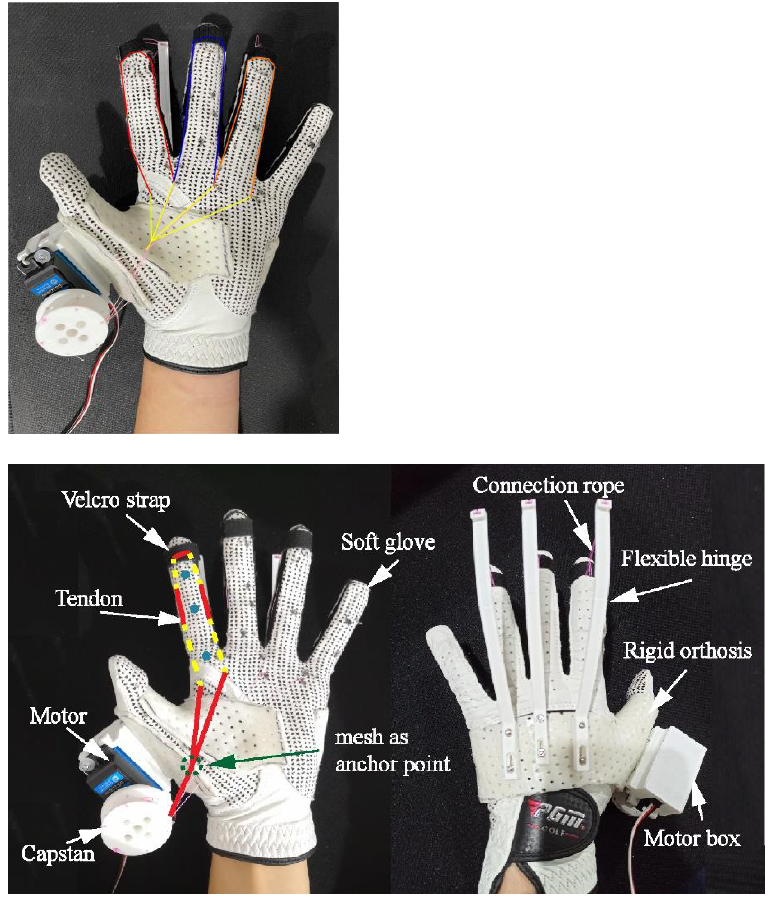
Figure 6. Components of the novel hybrid-driven compliant hand exoskeleton. (Volar and dorsal body of the hand exoskeleton are on the left and right, respectively).